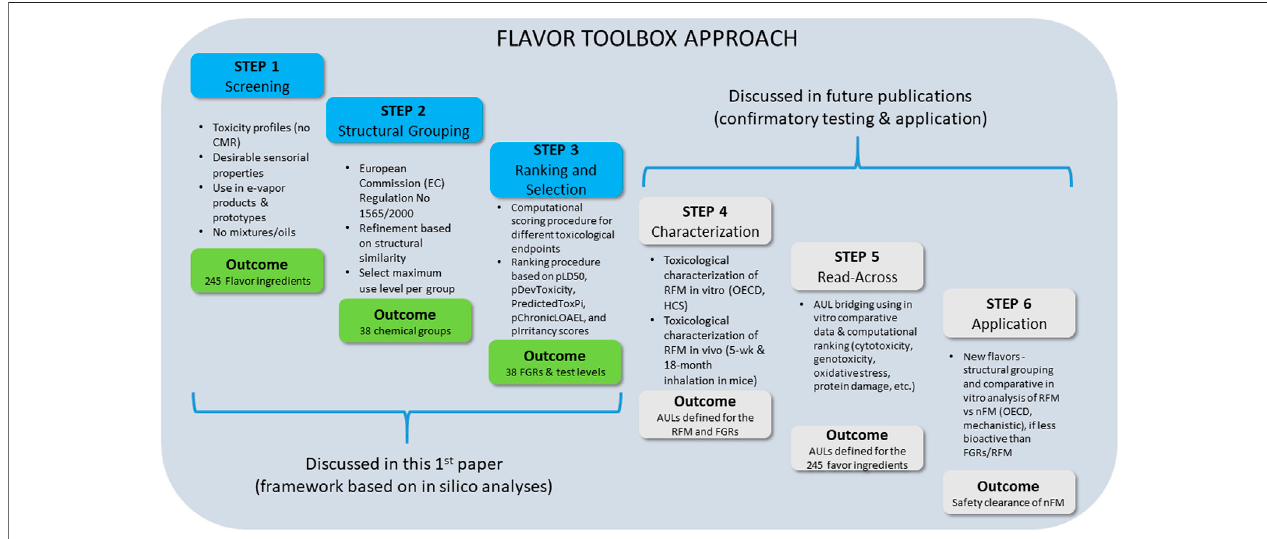
FIGURE 2 | Step by step description of the “ fl avor toolbox ” approach (*Disclosures at scienti fi c meetings, see Supplementary Resource S1 )